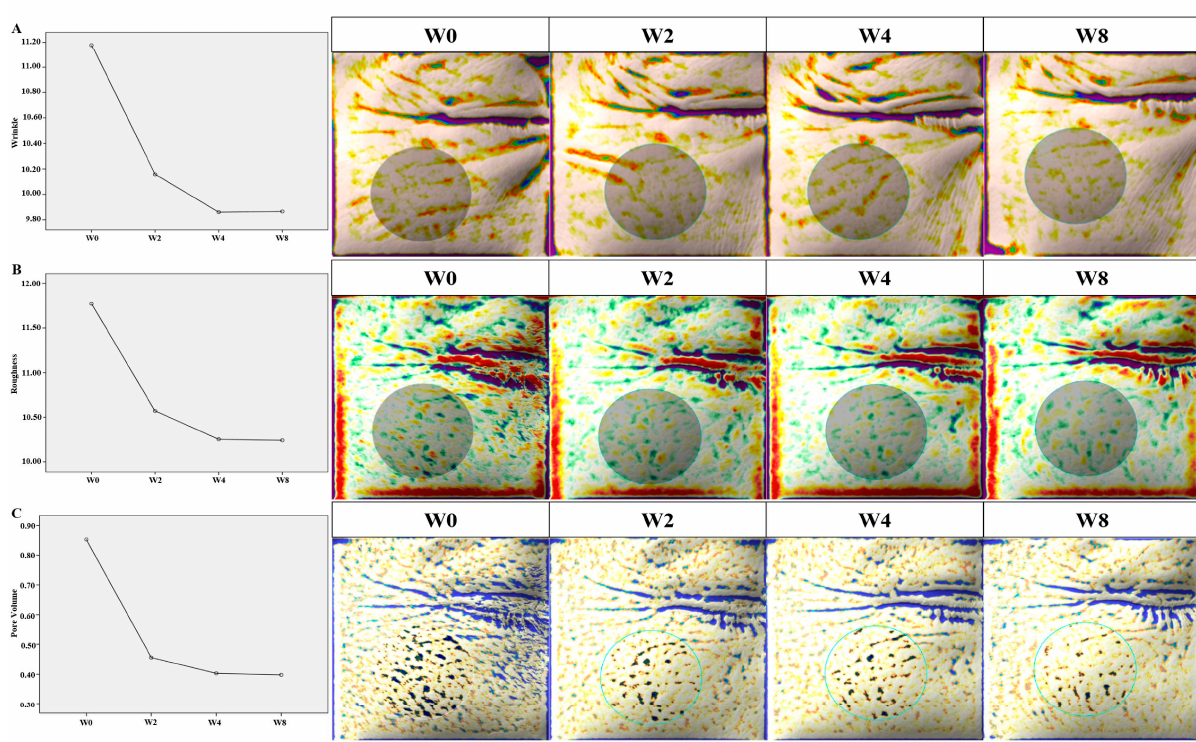
Figure 5. The improvements in wrinkles, roughness, and pore volume measured by the Antera 3D image capture system ® . ( A ) The wrinkles improved by 11.72% from week 0 (W0) to week 8 (W8) ( p < 0.001). ( B ) The roughness improved by 13.00% from W0 to W8 ( p < 0.001). ( C ) The pore volume was reduced by 52.94% from W0 to W8 ( p <